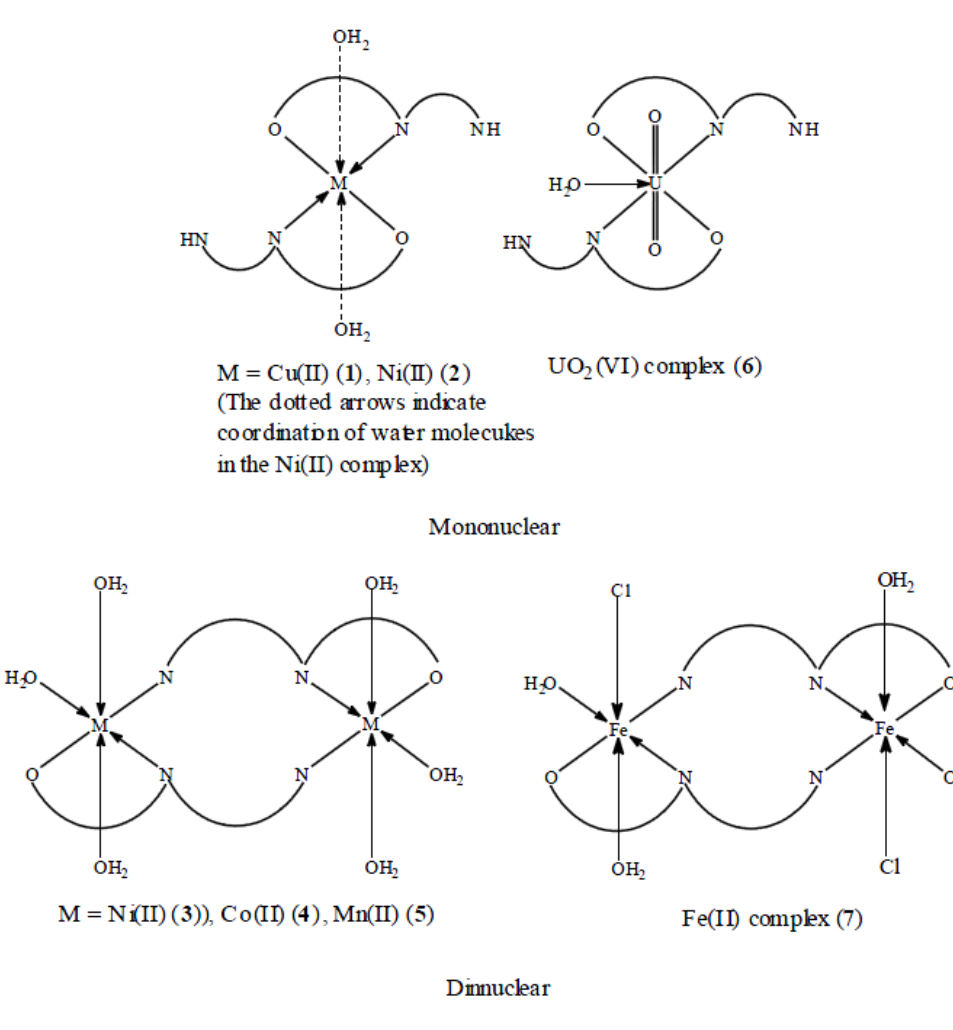
Figure 4. Suggested structures of the metal complexes of the ligand